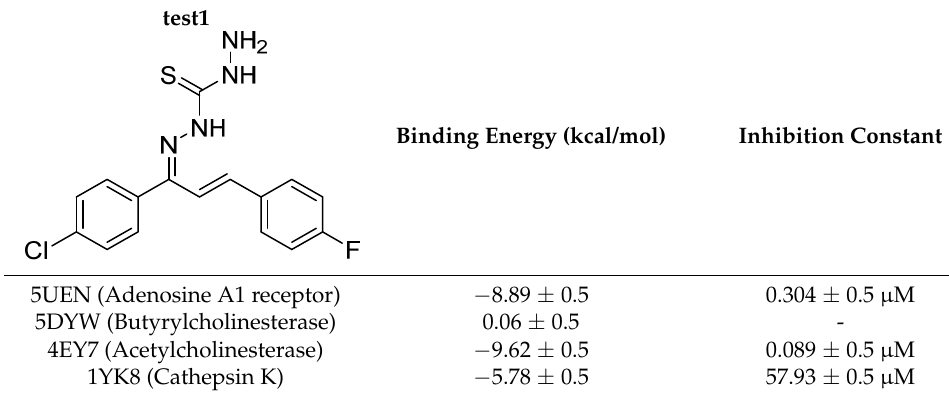
Table 7. Molecular binding results of compound test1 with four macromolecules.